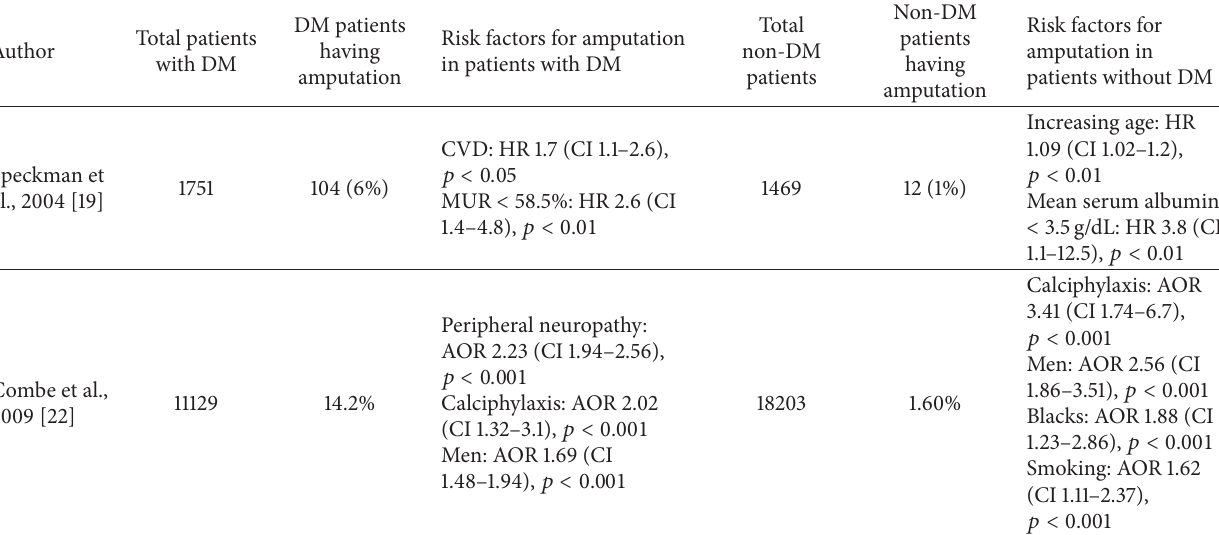
Table 3: Summary of studies assessing risk factors of amputation in diabetic and nondiabetic patients on